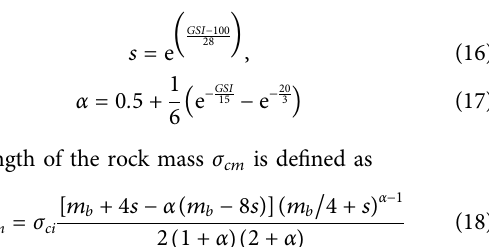
22 . 056 MPa and σ x (cid:2) σ h, min (cid:2) 11 . 492 MPa , and these stresses were maintained for 181 h or longer. The bottom and left side the vertical and horizontal directions, respectively.